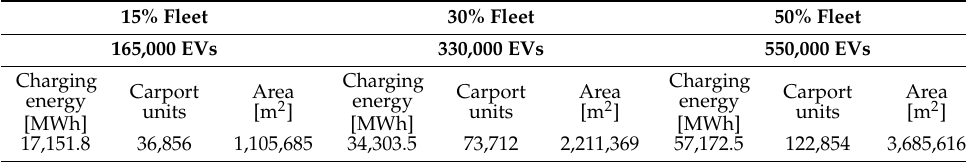
Table 8. Comparison of the